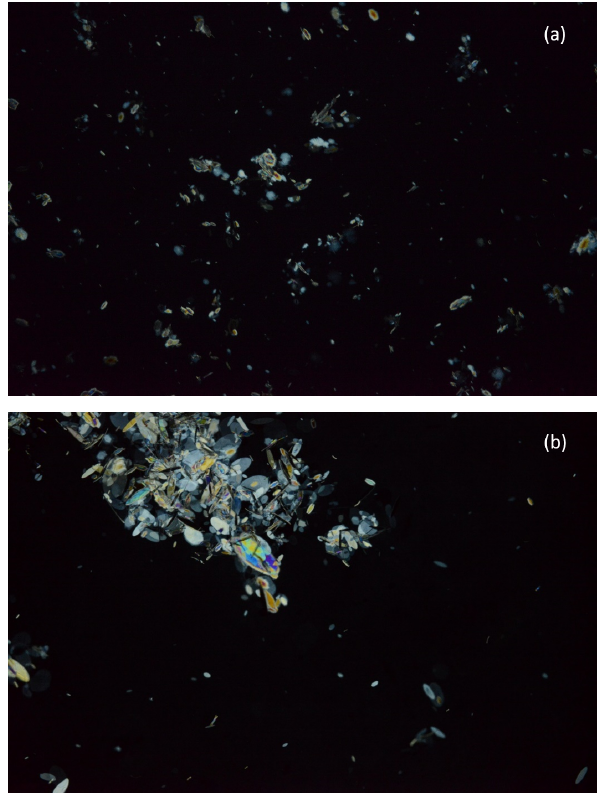
Figure 4. Raw digital images showing frazil particles and flocs for (a) 35‰ and (b) freshwater. Image dimensions are 3.07cm by